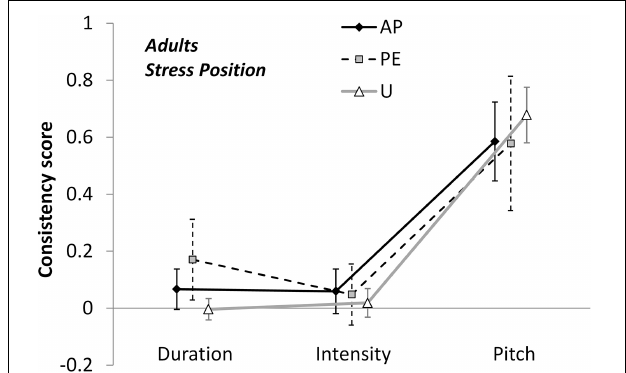
FIGURE 4 | Consistency scores by Adults are plotted against Parameter, as a function of Stress Position (AP, antepenultimate; PE, penultimate; or U, ultimate). Error bars are 95% confidence intervals.